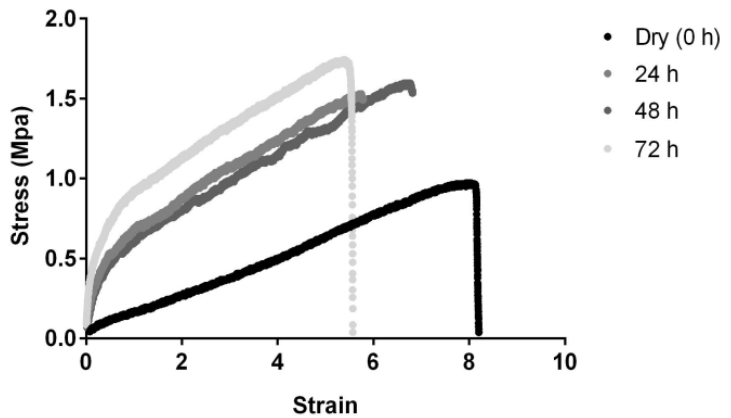
Figure 7. Representative tensile stress–strain curves of Biofiber prototypes in dry conditions (0 h) and after incubation in SWF (34 °C, 24 – 72 h, RH Ambient). Table 2. Mepilex Lite ® , Biatain ® Alginate, and Biofiber ΔL % of dry vs. wet conditions (SWF, 34 °C for 72 h). Statistically significant values are indicated as * p < 0.05, ** p < 0.01, *** p < 0.001, **** p < 0.0001. A two-way ANOVA test was performed to evaluate data significance.